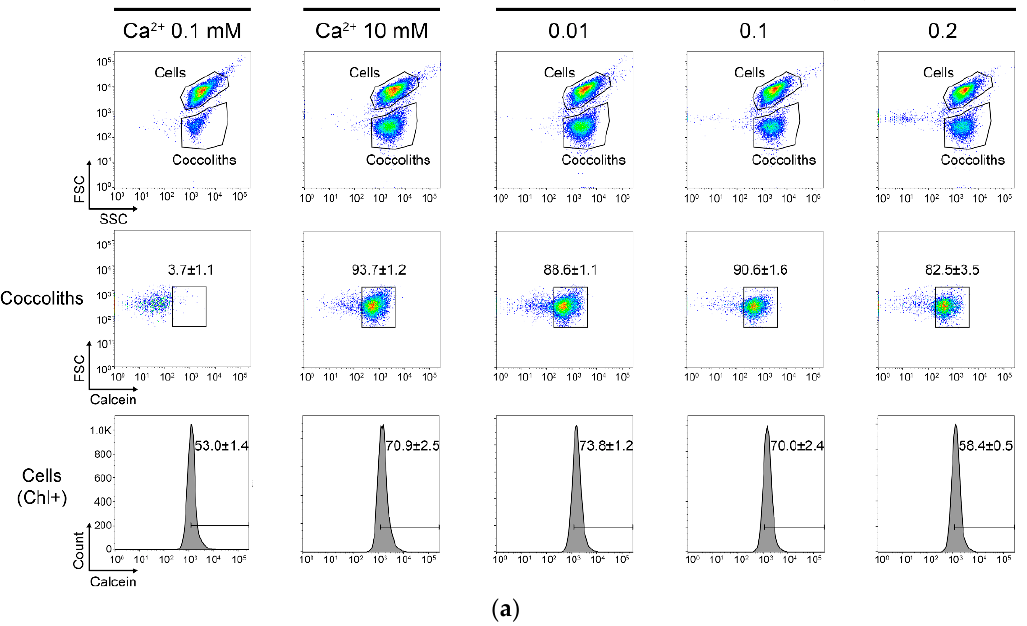
( b ) ( c ) Figure 4. Effect of the PI-PLC inhibitor U73122 on calcium-induced coccolith production analyzed using a flow cytometer in E. huxleyi CCMP 371. Cell growth data are provided in Figure S2. To provide samples, we transferred cells grown in 0.1 mM [Ca 2+ ] (- Control) to 10 mM [Ca 2+ ] (on Day 1 in Figure S2) and incubated them for 72 h without (+ Control) and with 0.01, 0.1, and 0.2 μ M U73122 (until Day 4 in Figure S2). ( a ) Data of forward scatter (FSC) vs. side scatter (SSC) (top), and FSC vs. calcein- positive populations estimated from the coccolith-gated population (middle) and cells (chlorophyll- positive, Chl+) (bottom). ( b ) Merged histograms of counts vs. calcein-positive populations in cells